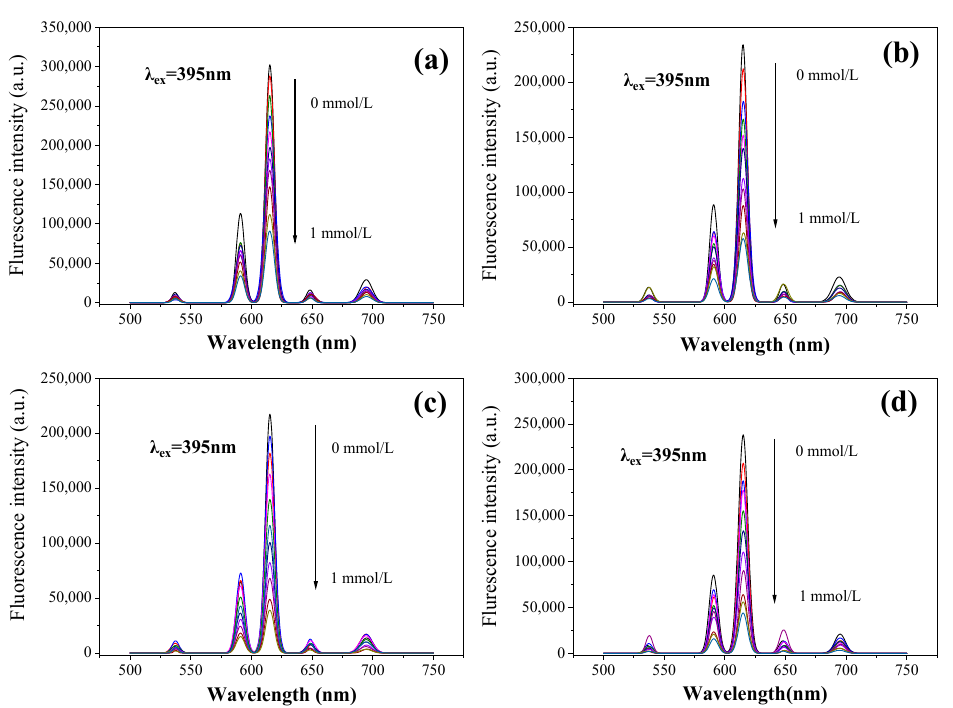
Figure 8. The effect of acrylamide standard solution on fluorescence intensity of CMC/Eu (III) fluorescent probe in ( a ) waterborne food simulants, ( b ) acidic food simulants, ( c ) alcoholic beverage simulants, and ( d ) greasy food simulants.